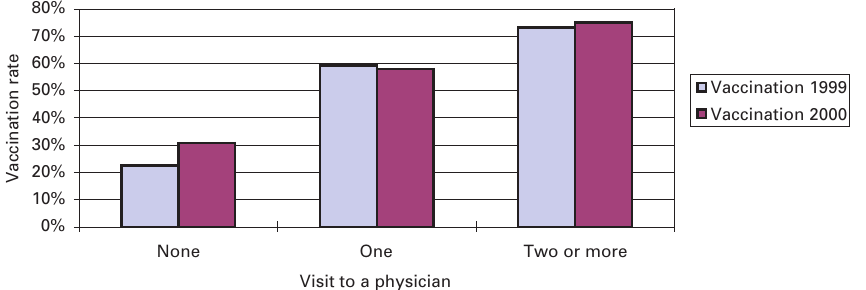
Survey 2000 and 2001: vaccination rate 1999 (N = 2664) and 2000 (N = 2789) and the frequency of visit to a physi- cian.